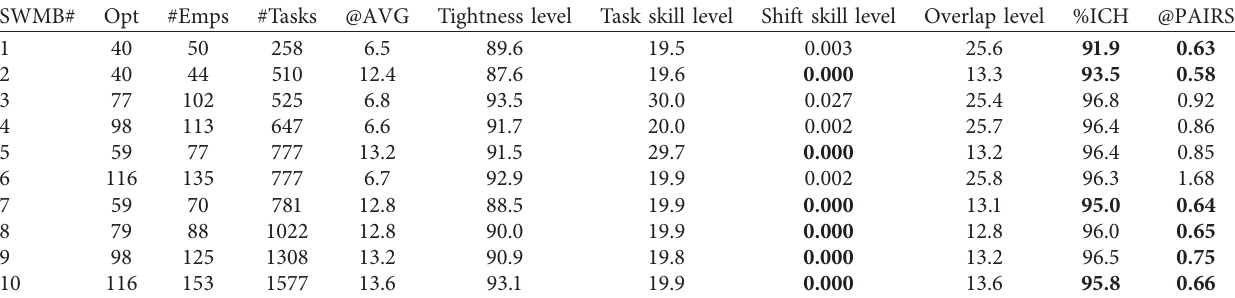
Table 2: The characteristics of the 10 SWMB instances.